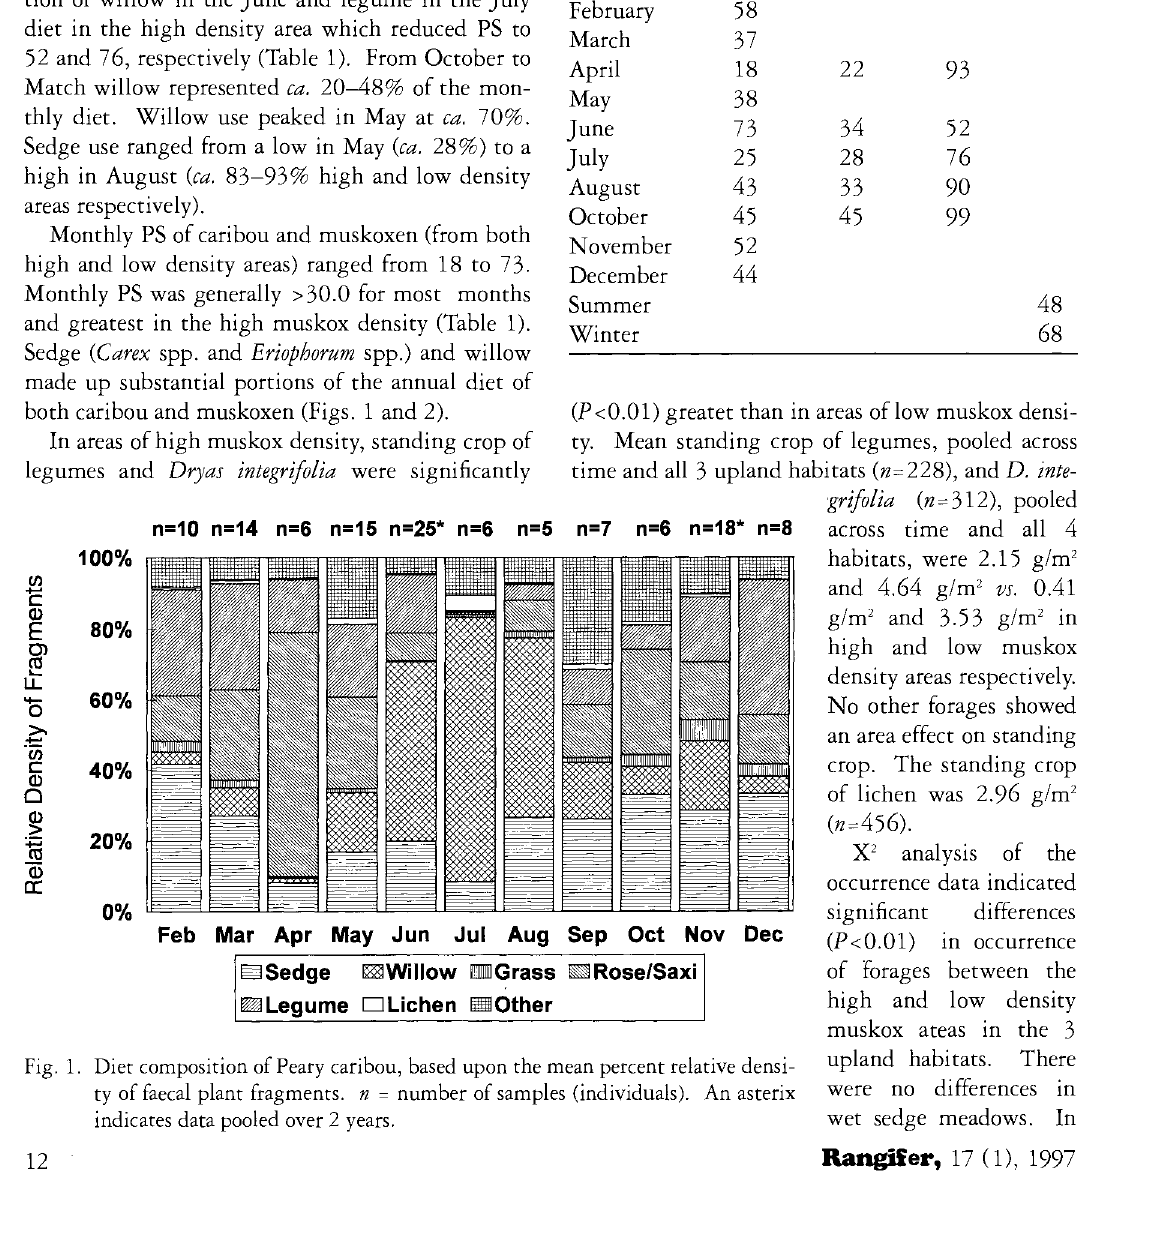
Table 1. The Renkonen index of percent similarity (PS) of the monthly diets of caribou and muskoxen in high density areas (C/MH), caribou and mus koxen in low density areas (C/ML), and musko xen in high and low density areas (MH/ML) determined from this study. The PS of the sea sonal diets of caribou and muskoxen in 1972-73 (C/M of summer and winter found at the bottom of the table ) is based upon analysis of the data in Shanked/. (1978) and Wilkinson etal. (1976).